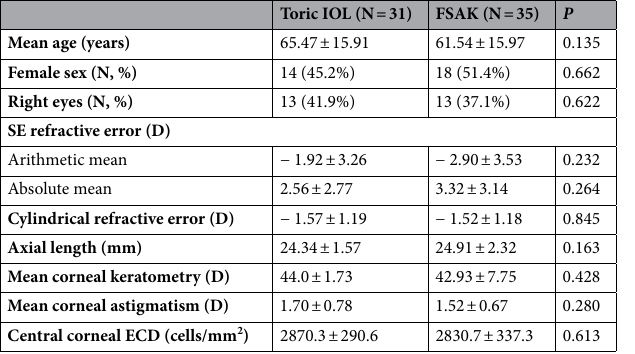
Table 1. Preoperative patient demographics and baseline values. MAR minimal angle of resolution, D diopter, RMS root-mean square, ECD endothelial cell